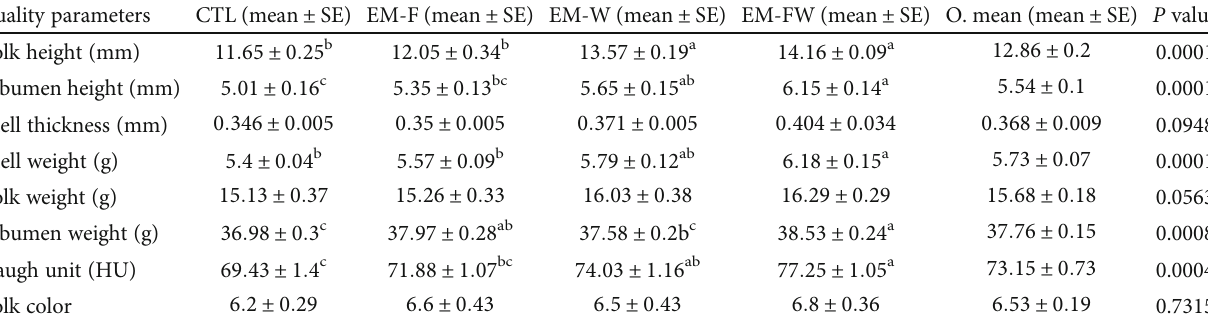
Table 6: The e ff ect of EM supplementation on internal and external egg quality. Quality parameters